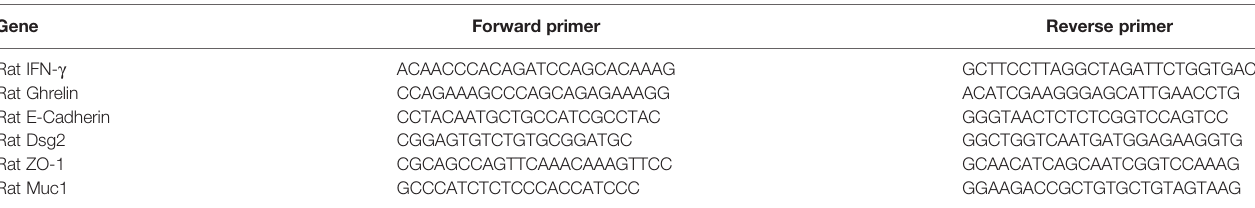
TABLE 1 | Primers